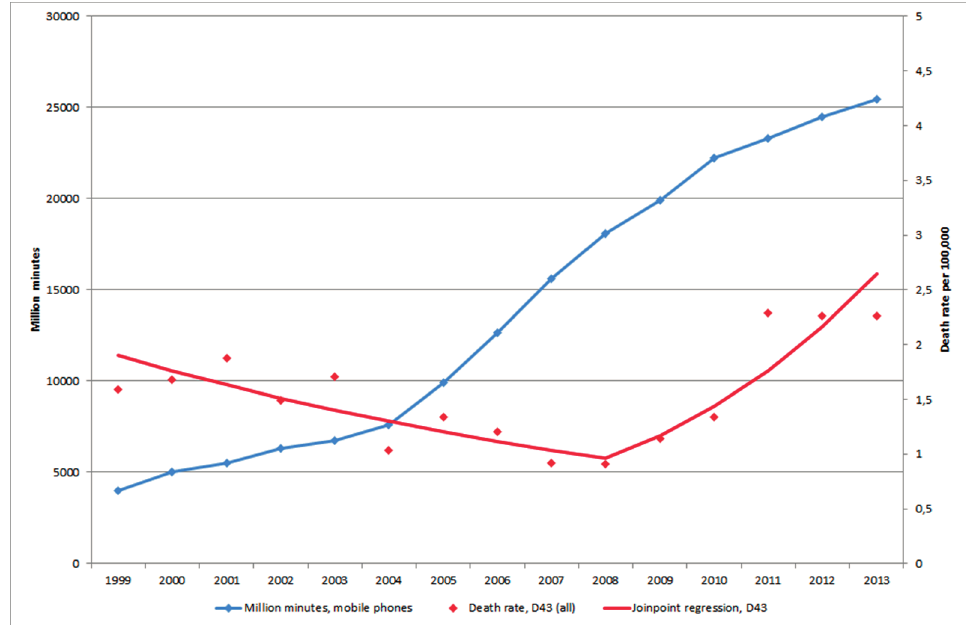
Figure 6. Number of out-going mobile phone minutes in millions during 1999–2013 [33] and joinpoint regression analysis of age-standardized death rates per 100,000 inhabitants according to the Swedish Causes of Death Register for all ages during 1999–2013 diagnosed with D43 = tumour of unknown type in the brain or CNS [29].